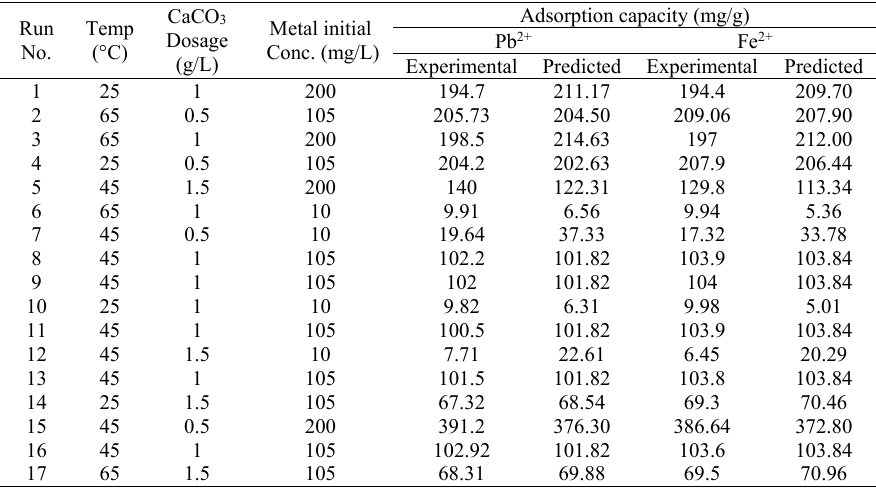
Table 4: Experimental design and experimental/predicted responses for Pb 2+ and Fe 2+ removal Run No.